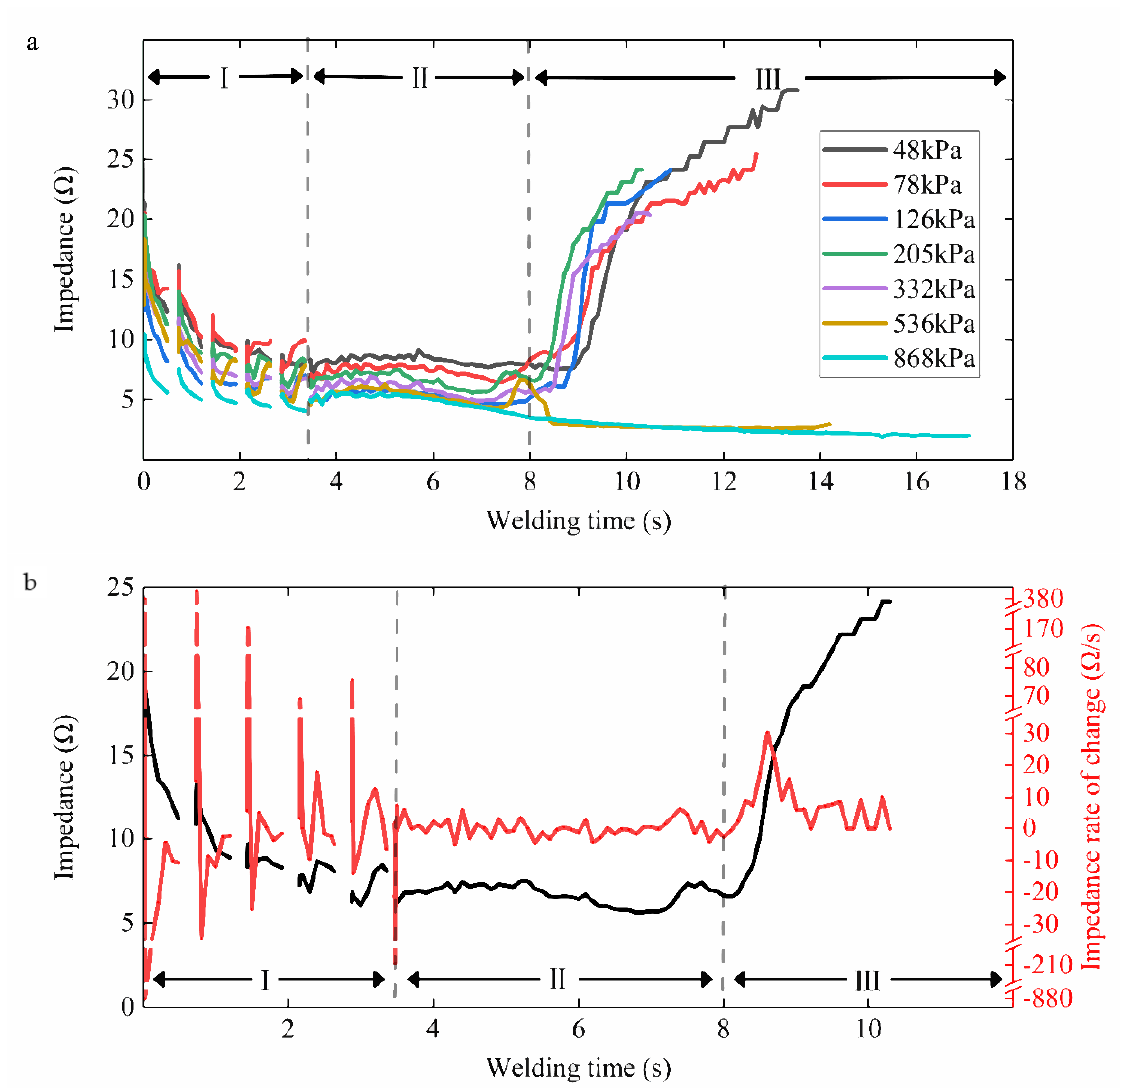
Figure 6. ( a ) Dynamic impedance under seven levels of initial compression pressure. The impedance curve is divided into three stages. The time of impedance reduction is Period I, about 0 − 3.6 s. Period II is the smooth period of impedance change, about 3.6 − 8 s. Impedance of Period III shows two trends due to differences in initial compression pressure. The impedance would suddenly increase when the compression pressure is less than 332 kPa. There would be an inflection point due to water evaporation and collagen reorganization when Period III is the key to high-strength connections. The impedance would continue to decrease under the pressure of 536 kPa and 868 kPa. ( b ) Impedance plot with the corresponding rate of change from small intestinal tissue of serosa–serosa anastomosis under 205 kPa. The rate of impedance change fluctuates very sharply in Period I, far exceeding the rate of impedance rise in Period III that follows. Relatively, the impedance itself is more stable and simpler to use as